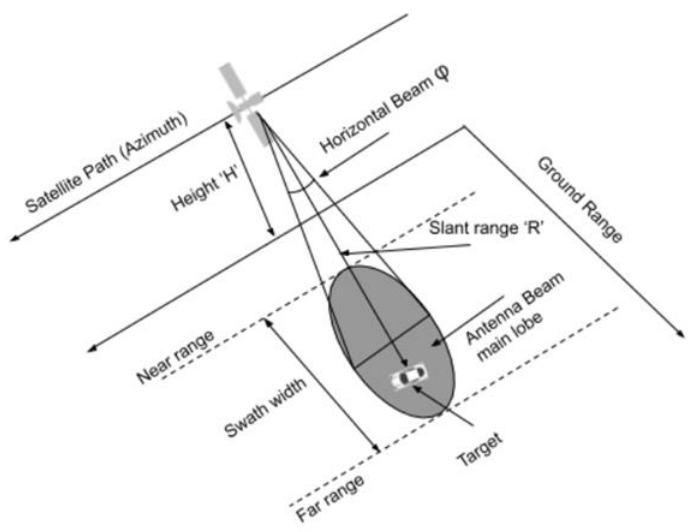
Figure 3. Satellite SAR image acquisition geometry.